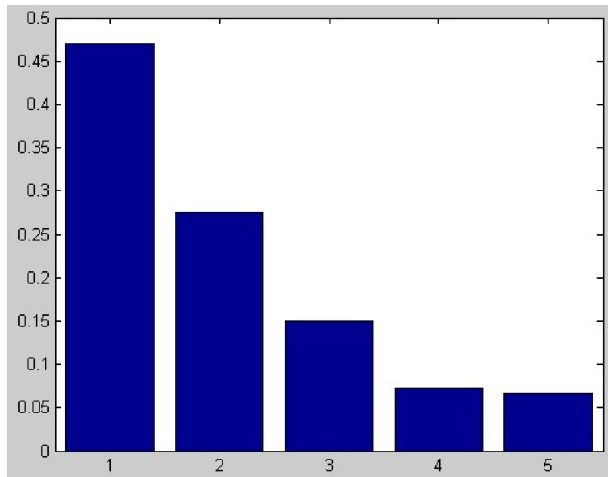
Figure 3. Explained degree of all independent variables